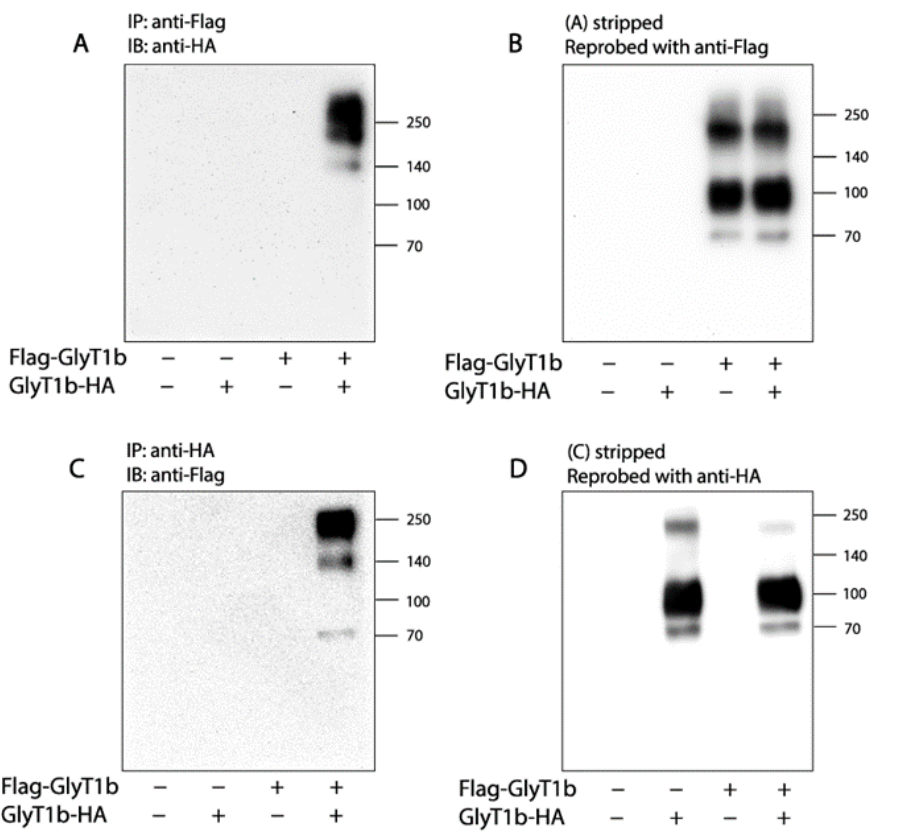
Figure 1. Association of two epitope-tagged GlyT1 forms. ( A,B ) Co-immunoprecipitation of FLAG-GlyT1 with GlyT1-HA. FLAG-tagged GlyT1 in total lysates of the cells co-expressing FLAG-GlyT1 with GlyT1-HA was pulled down by anti-FLAG agarose beads and subjected to separation by SDS-PAGE. The HA-tagged GlyT1 associated with FLAG-GlyT1 was then detected by immunoblot analysis with anti-HA antibody ( A ). After stripping, the immunoprecipitated FLAG-tagged GlyT1 was detected by re-probing the membrane with anti-FLAG antibody ( B ). ( C,D ) Co-immunoprecipitation of GlyT1-HA with FLAG-GlyT1. The HA-tagged GlyT1 was pulled down from cell lysates using anti-HA agarose beads and separated by SDS-PAGE. The FLAG-GlyT1 associated with GlyT1-HA was detected by immunoblot analysis with anti-FLAG antibody ( C ). Immunoprecipitation of the HA tagged GlyT1 was confirmed by anti-HA antibody ( D ). Graphs show representative blots, and experiments were performed more than three times with similar results.